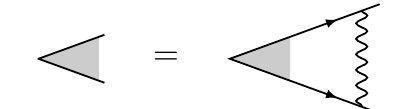
Figure 3: The linearized gap equation for the Cooper pairing vertex. See Eq.